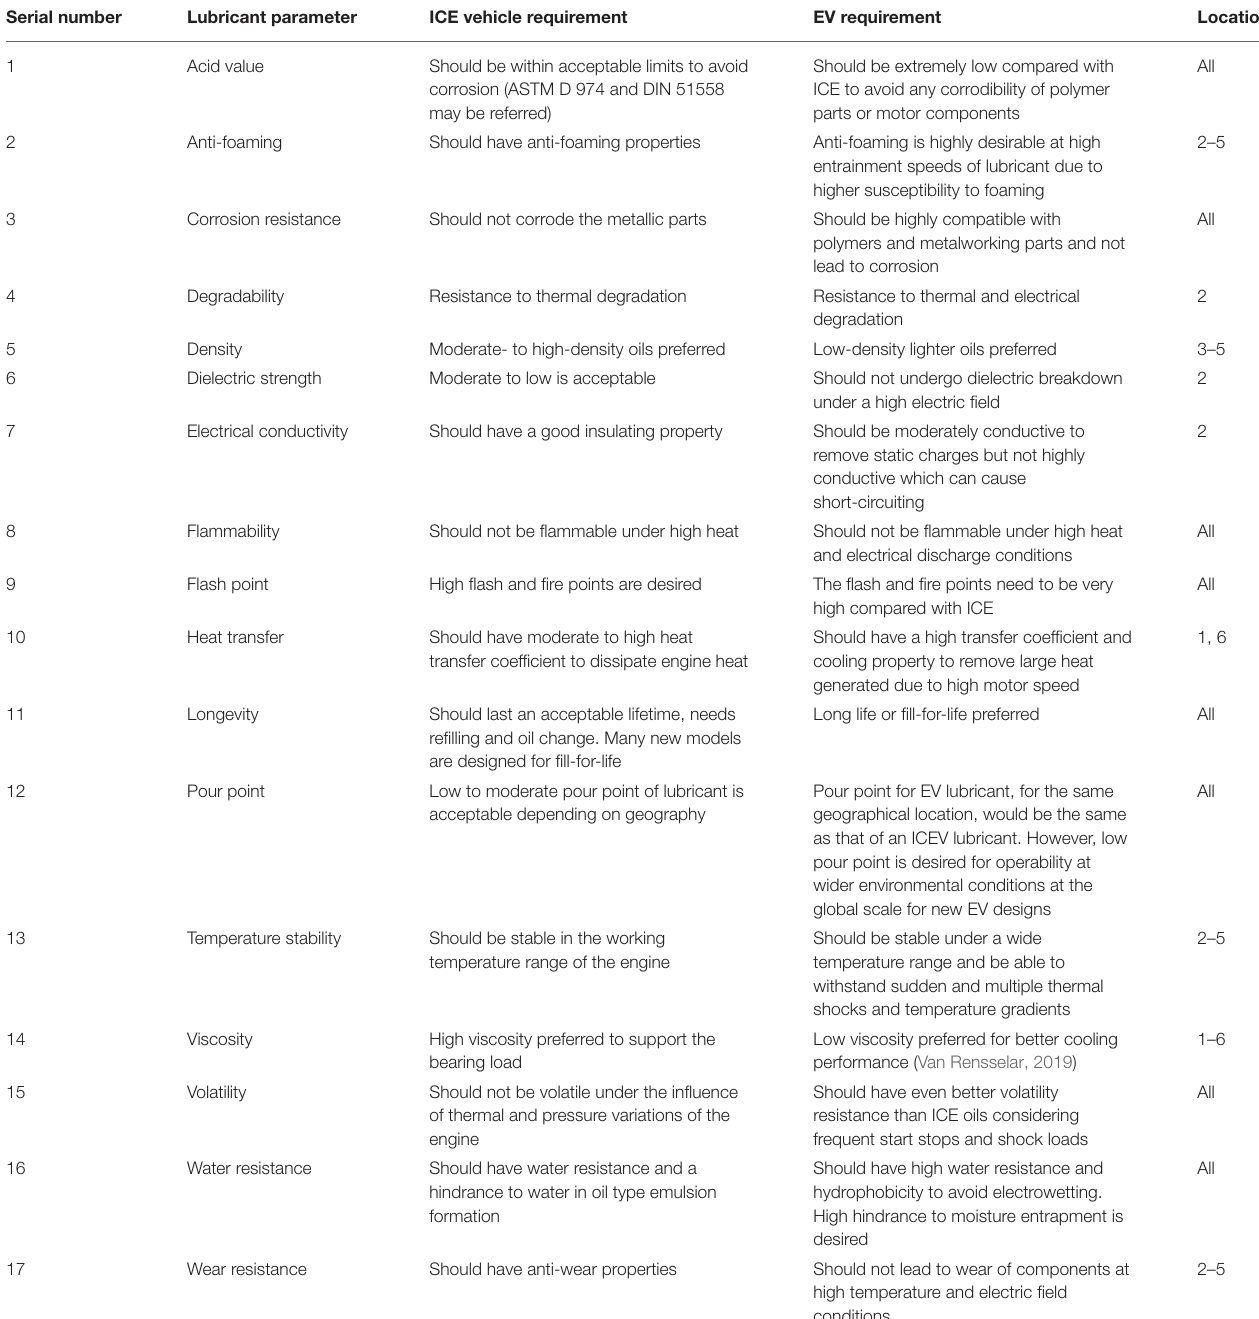
TABLE 6 | Comparison of lubrication requirements for ICE vehicles and